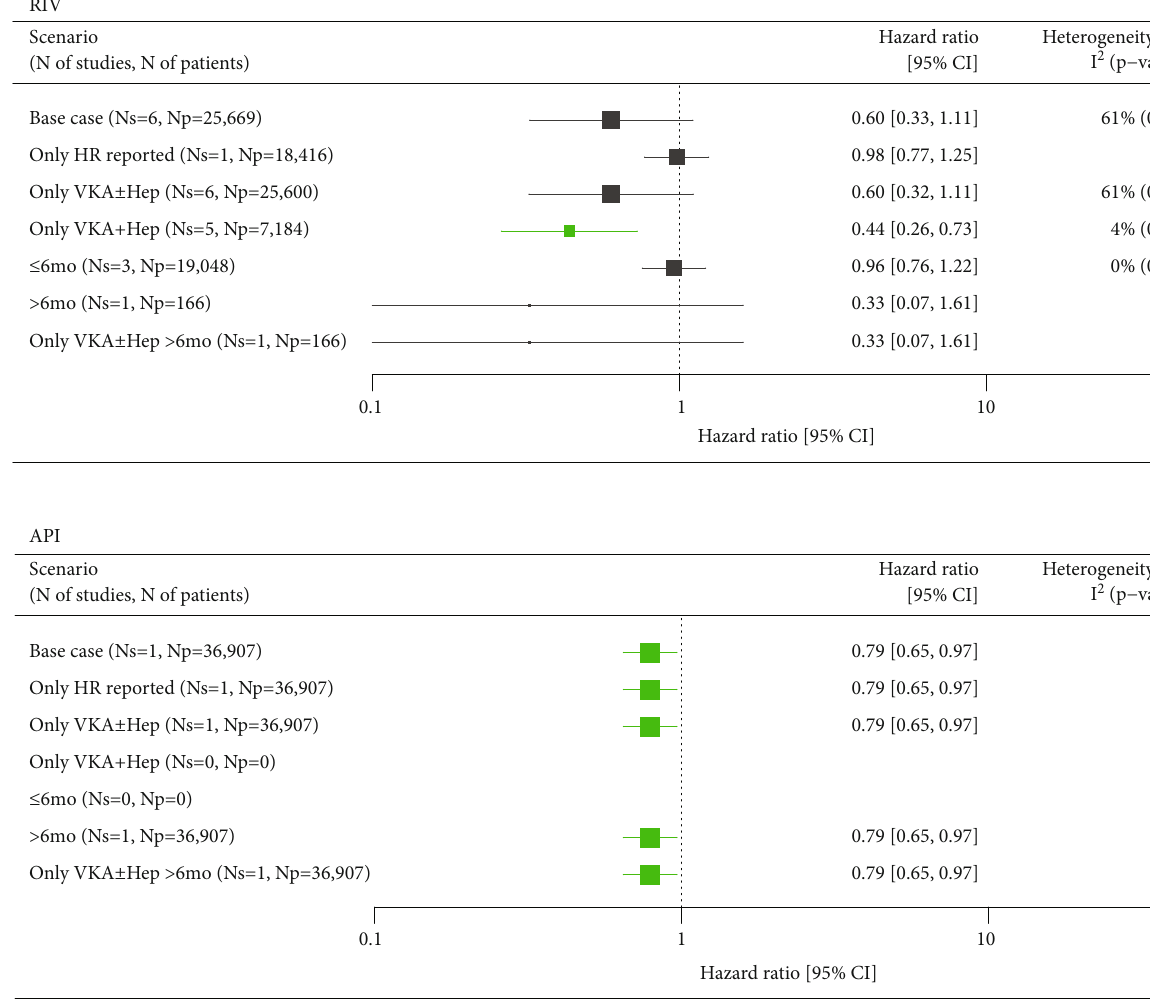
Figure 3: Summary of meta-analyses comparing RIV and API versus SoC in VTE for the recurrent DVT. API: apixaban; CI: con fi dence interval; DVT: deep vein thrombosis; HR: hazard ratio; Np: number of patients; Ns: number of studies; RIV: rivaroxaban; SoC: standard of care; VKA ± Hep: vitamin K antagonist ± heparins; VTE: venous thromboembolism; N/A: not applicable. Green marks represent results indicating statistically lower event rate in the NOAC